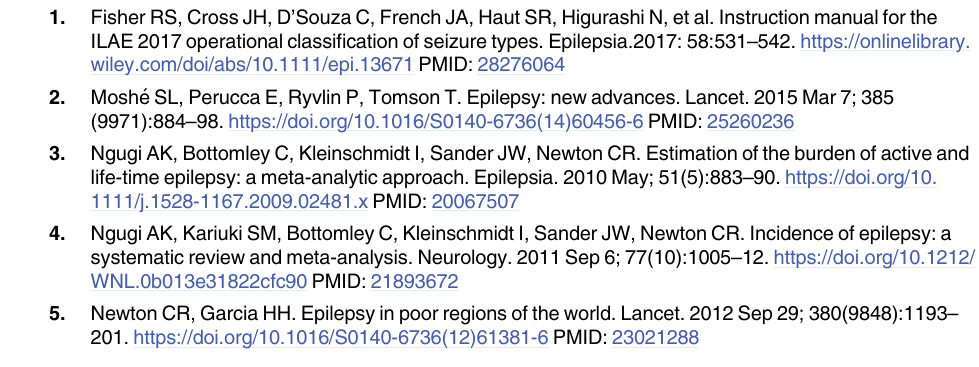
S1 Table. Comparison of average socio-demographic and obstetric outcome variables between pregnant women with and without epilepsy. DOI: 10.21203/rs.3.rs-1523664/v1.